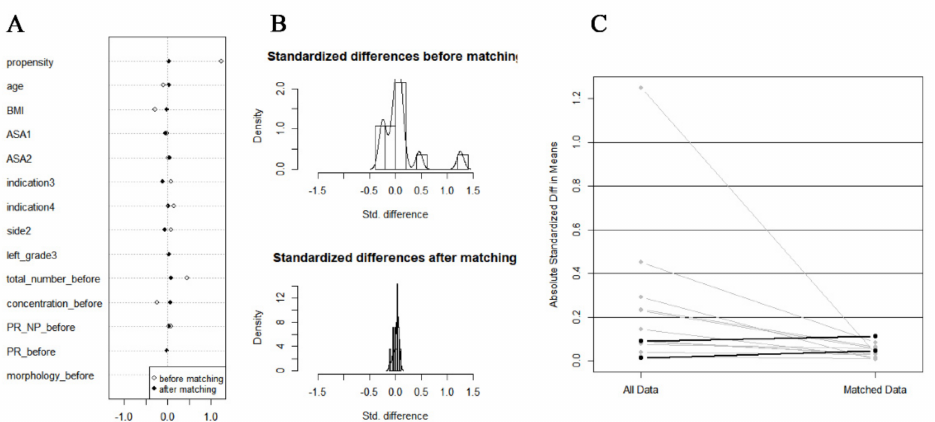
Figure 3. The plot of the propensity score-matched study. ( A ) Dot plot of standardized mean difference. ( B ) Histogram of standardized mean differences (before and after). ( C ) Line plot of individual